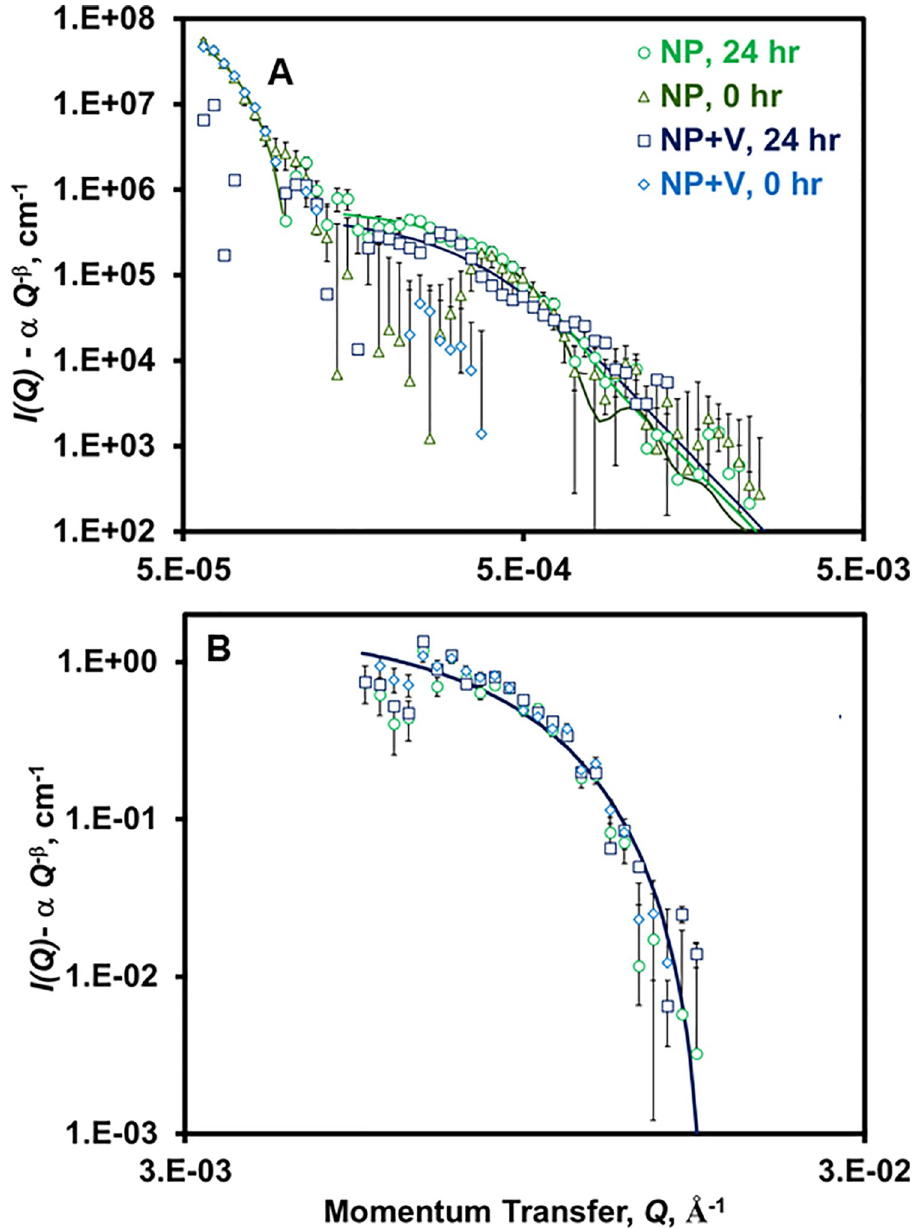
Fig 3. Schulz polydisperse sphere form factor model fitting of (A) USANS and (B) SANS “excess” scattering data ( I(Q) from Fig 2A minus power law fit from Fig 2B). Model parameters are given in Table 1. V and NP refers to vermiculite and nanoplastics, respectively. Experimental conditions are given in Fig